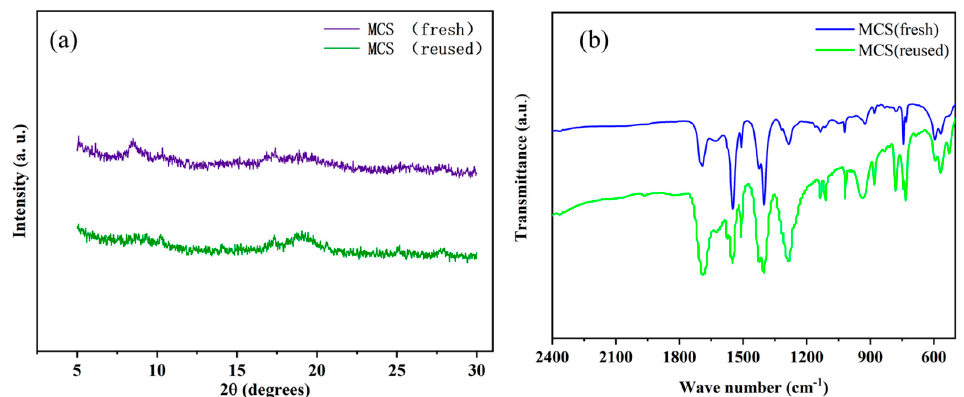
Figure 9. XRD patterns ( a ) and FT-IR spectra ( b ) of the fresh and reused MCS catalysts.